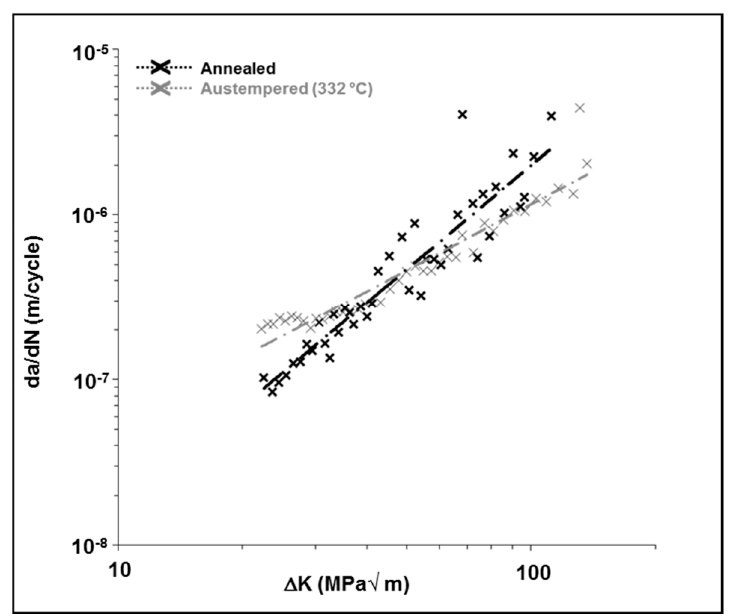
Figure 11. The Effect of Austempering on the Fatigue Crack Growth Rate of the 4140 Steel Hydrogen-Charged for 250 h.